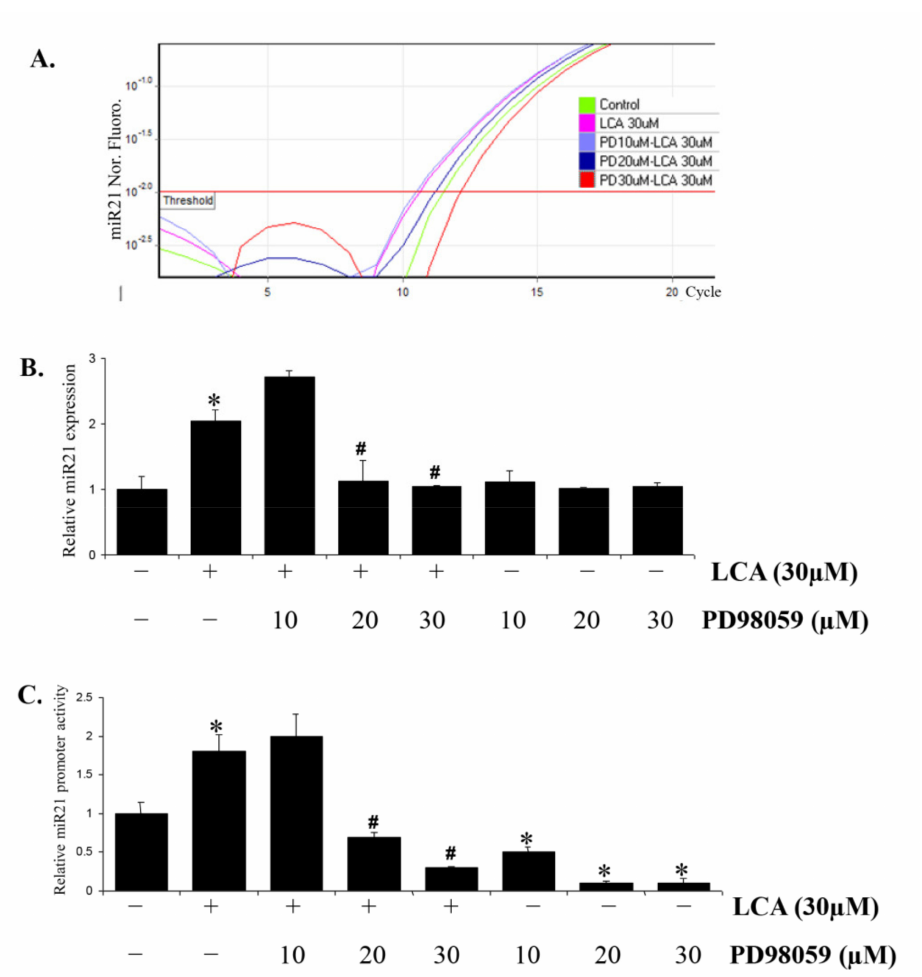
Figure 3. Erk1/2 signaling is involved in LCA-induced miR21 through AP-1 transcription fac- tor activation. ( A , B ) HCT116 cells were treated to PD98059 1 h prior to LCA treatment for 24 h. The cells were then harvested and checked for miR21 expression by Realtime-PCR. ( C ) HCT116 cells transfected with pGL3-miR21 promoter were treated with PD98059 and then 30 µ M LCA for 24 h. The cells were then lysed and subjected for dual-luciferase assay for miR21 promoter activity. * p < 0.05 versus control; # p < 0.05 versus only LCA. The above data represent the means ± SD from triplicate